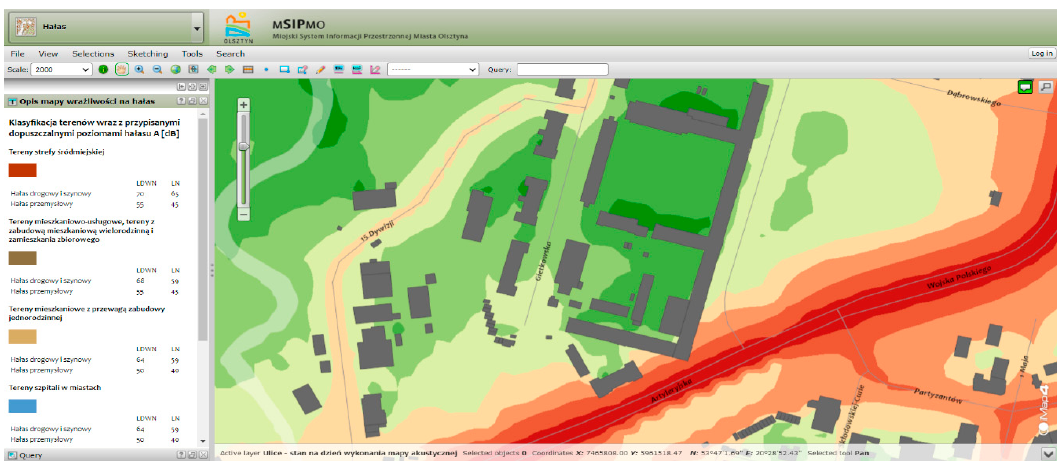
Table 1. Geoportal functionalities (data and service coverage), own study based on data from Raport https: // inspire.ec.europa.eu / documents / summary-report-status-implementation-inspire-dire ctive-eu and